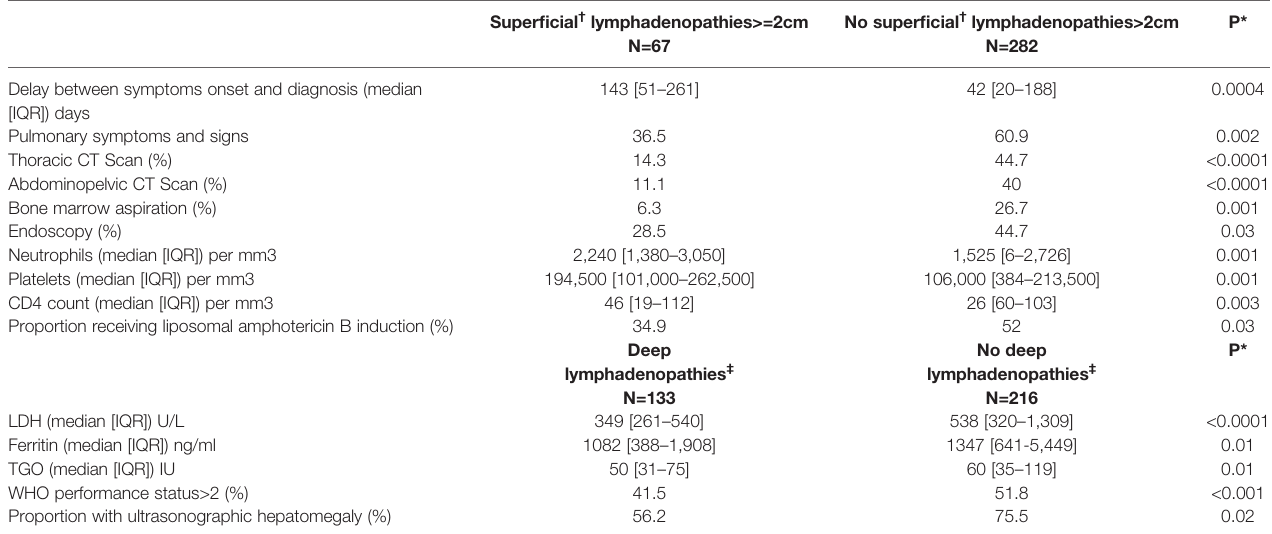
TABLE 2 | Comparisons between patients with and without large super fi cial lymphadenopathies (>2 cm), and with and without deep lymphadenopathies.